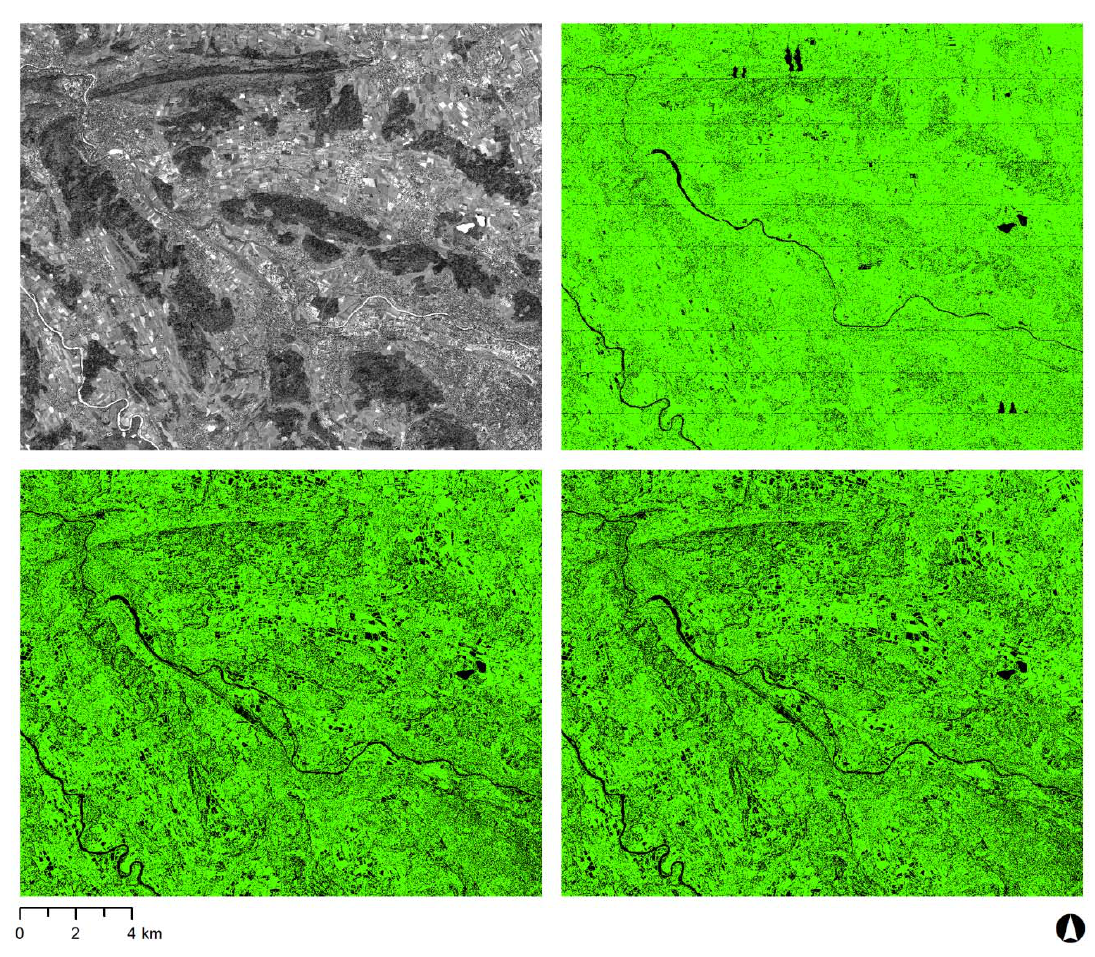
Figure 2. WorldView-2 Pan scene (top left) and figure of merit (FOM) maps of the three DSMs (WorldView-2 RPCs-only DSM, WorldView-2 GCP-enhanced RPCs DSM and ADS80 DSM). Pixels displayed in green were matched successfully and incorporated in the subsequent analysis. Pixels displayed in black are interpolated only and were masked out. FOM map of ADS80 DSM (top right; 87.45% matched cells and 12.55% interpolated cells), FOM map of WorldView-2 RPCs-only DSM (bottom left; 71.16% matched cells and 28.84% interpolated cells) and FOM map of WorldView-2 GCP-enhanced RPCs DSM (bottom right; 71.43% matched cells and 28.57% interpolated